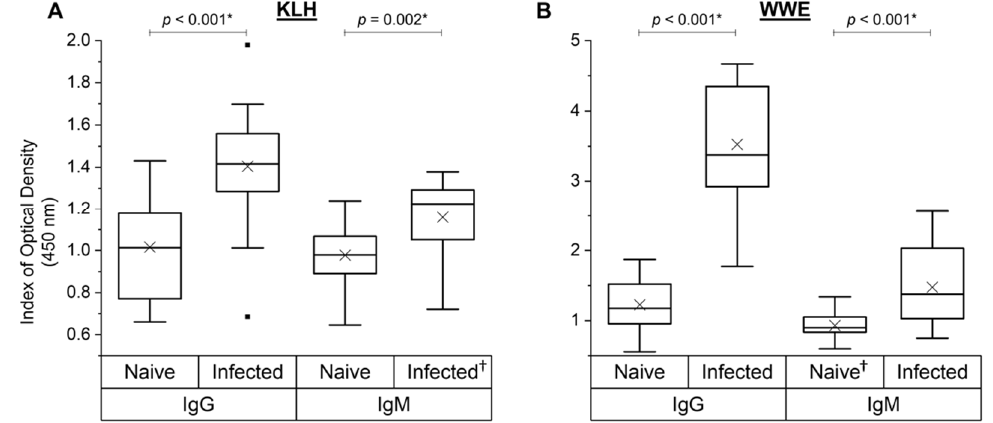
Figure 6. Analysis of natural and specific antibody levels for experimentally infected animals from cows in studies A, B and C ( n = 19). KLH-binding IgG and IgM ( A ) and liver fluke whole-worm extract (WWE)-binding IgG and IgM ( B ) on the day of experimental liver fluke infection (naïve) and 6 weeks post-infection (infected) were assessed. Data are presented as the mean index ( n = 4) of optical density (450 nm) in quartile box plots with a median line and a mean cross ( × ) for the experimentally infected animals. Any significant differences ( p < 0.05) in means are noted with an asterisk (*) in the graph (one-way ANOVA). † : datasets that had an outlier removed ( n = 18).